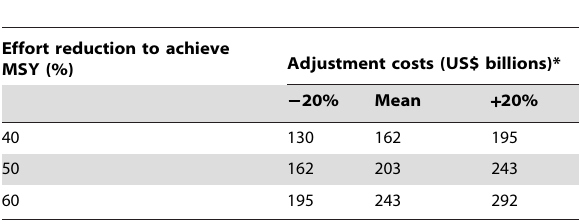
Table 6. Sensitivity of present value of rebuilding costs to parameter